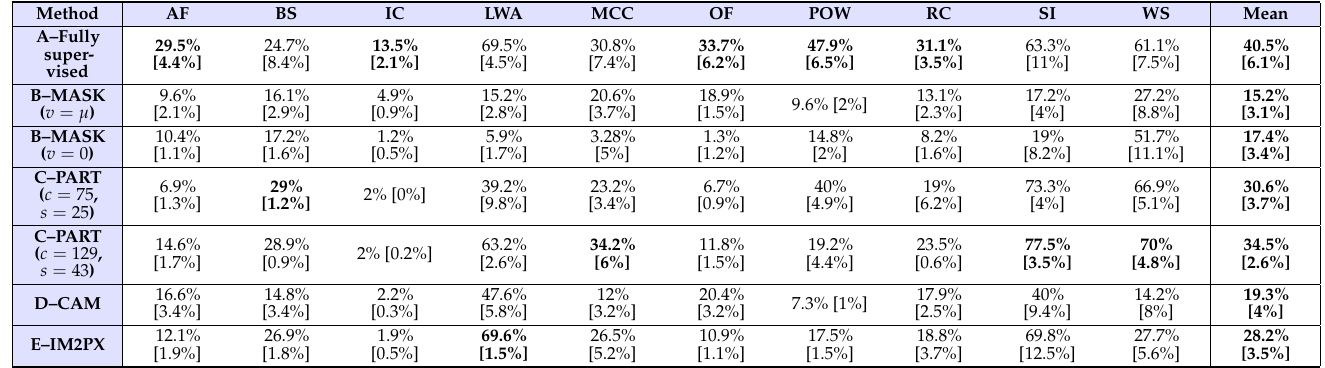
Table 2. Dice index for each algorithm and phenomena computed over the test set. A Dice equal to 1 means perfect overlap between the truth and the prediction. Values are given as mean and standard deviation over 10 trainings to account for the random initialization and order of the groundtruths used in the epochs.